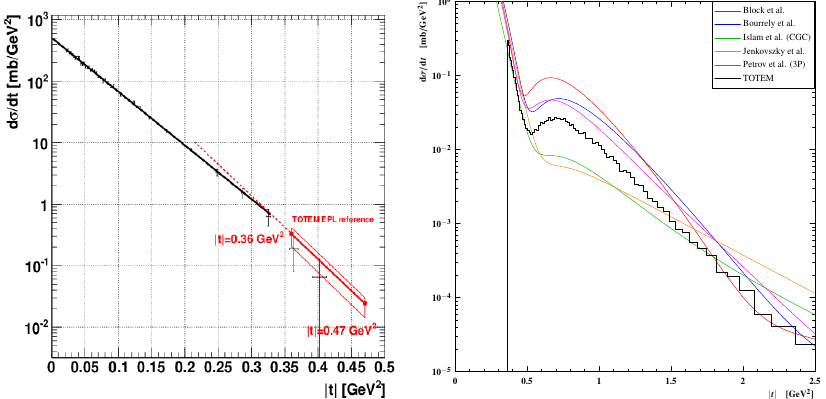
Fig. 3. The differential cross section of elastic proton-proton scattering at Figure 3. The differential cross section of elastic proton-proton scattering at the energy √ s = 7 TeV the energy √ s =7 TeV measured by the TOTEM collaboration. measured by the TOTEM collaboration. Left : The region of the diffraction cone with the Left: The region of the diffraction cone with the decrease [19]; Right : The region beyond the diffraction peak [20]. The predictions of five models Right: The region beyond the diffraction peak [20]. The predictions of five are demonstrated. models are demonstrated.